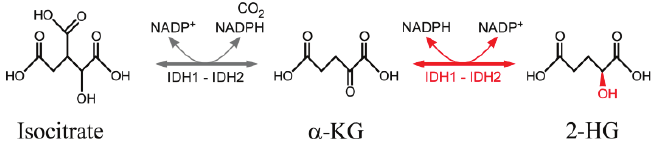
Figure 2. Conversion of isocitrate to α -ketoglutarate ( α -KG) by isocitrate dehydrogenases (IDH) enzymes and conversion of α -KG to D -2-hydroxyglutarate (2-HG) by gain-of-function mutations in IDH1 or IDH2